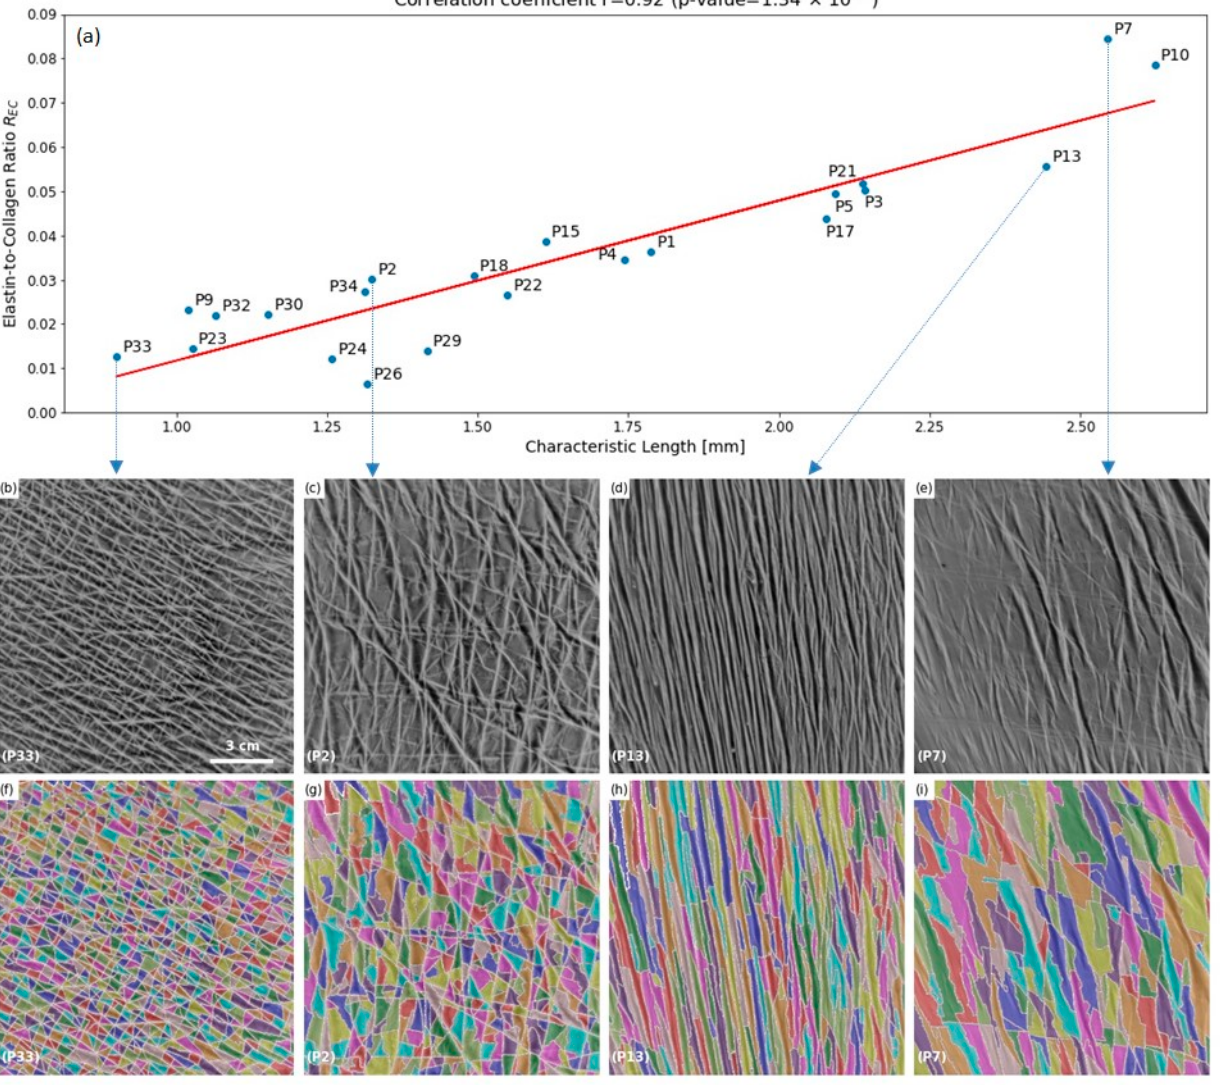
Figure 4. ( a ) Very strong correlation was found between Characteristic Length and the Elastin ‐ to ‐ Collagen ratio. Optical classification on raw ( b – e ) and segmented ( f – i ) images from lower SL/R EC at left to higher SL/R EC at right. ( b , f ) patient P33 (67 years old) showed a network of lines distributed in all directions in an isotropic and very dense manner; ( c , g ) patient P2 (92 years old) showed wider and more distant lines leading to a decrease of density with a slight predominance of vertical lines; ( d , h ) patient P13 (87 years old) showed only a set of parallel lines, all directed in a privileged direc ‐ tion close to the arm axis; ( e , i ) patient P7 (85 years old)showed almost no more lines.